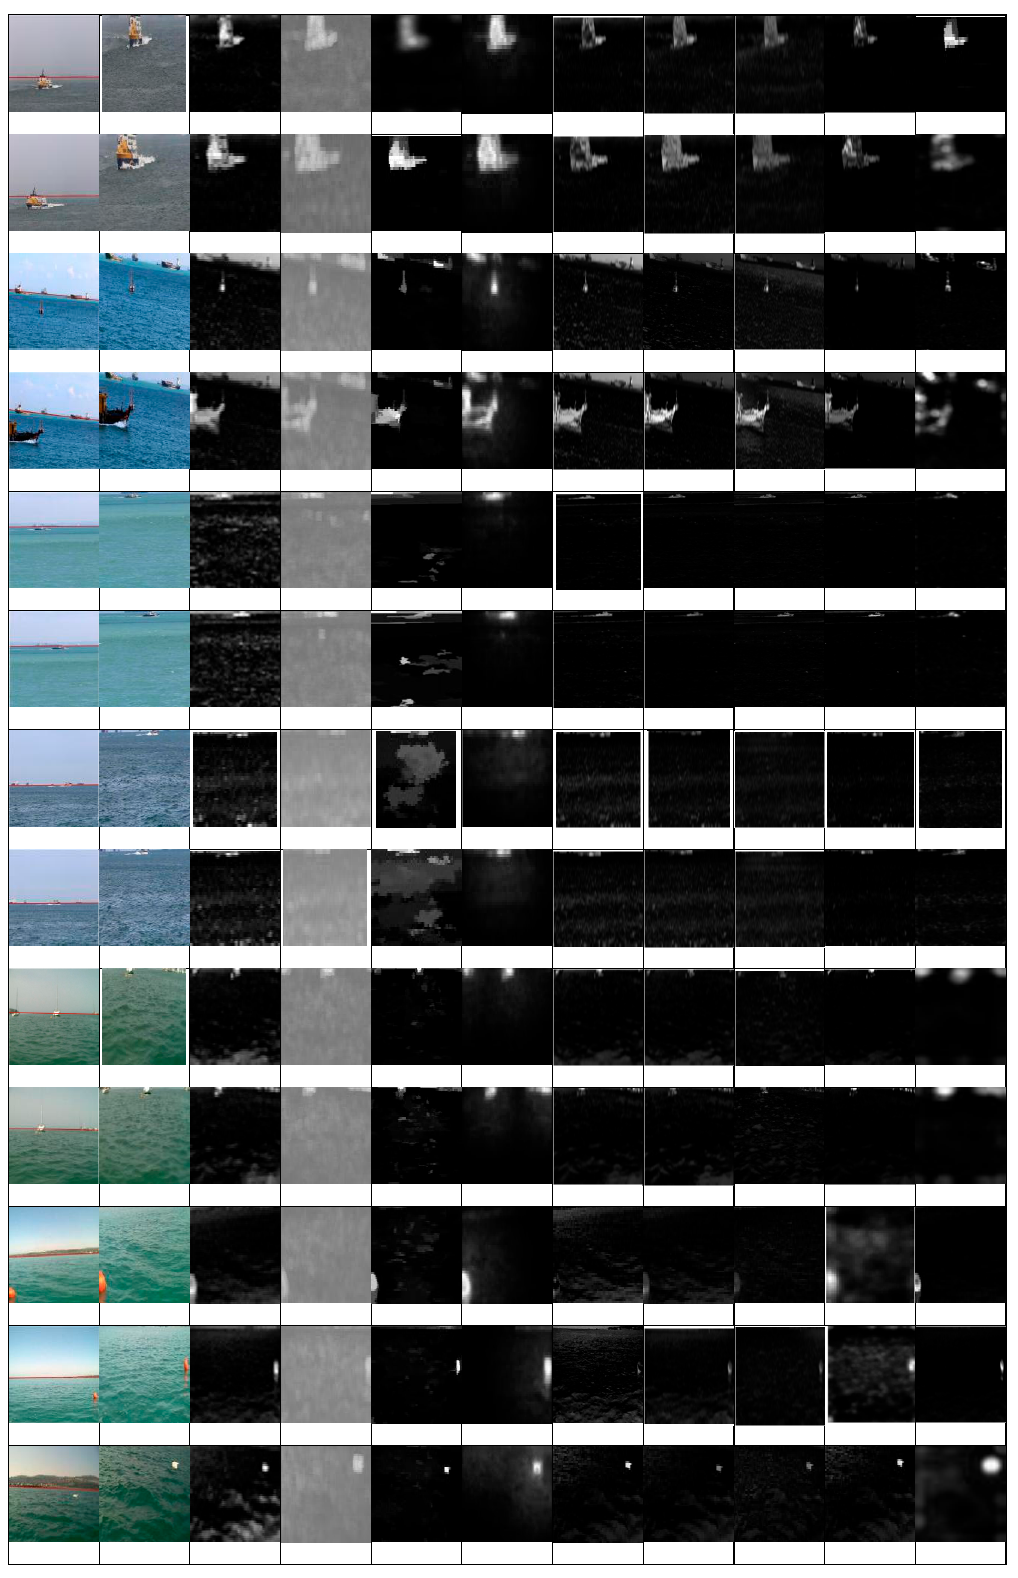
Figure 4. Examples of saliency maps generated using eight state-of-the-art models and the proposed model. Columns 1–8 and 9–13 correspond to the SMD and MOOD datasets. Columns 1–11 correspond to the sea-sky-line images, segmentation images and the images processed using the RWRV, AIM, DRFI, CA, SC, HC, SD, FT and proposed algorithms,